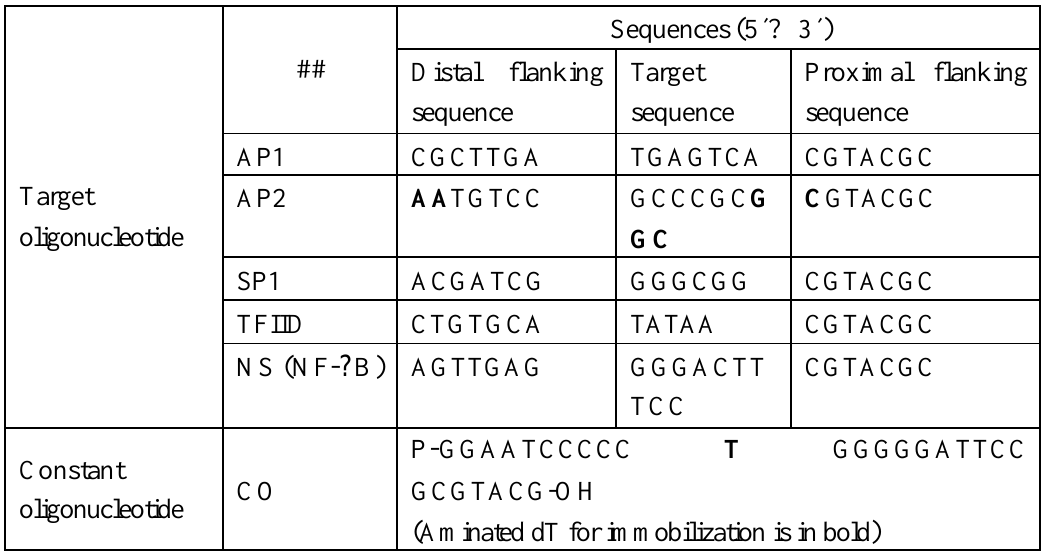
Table 1. Oligonucleotides synthesized to fabricate DNA